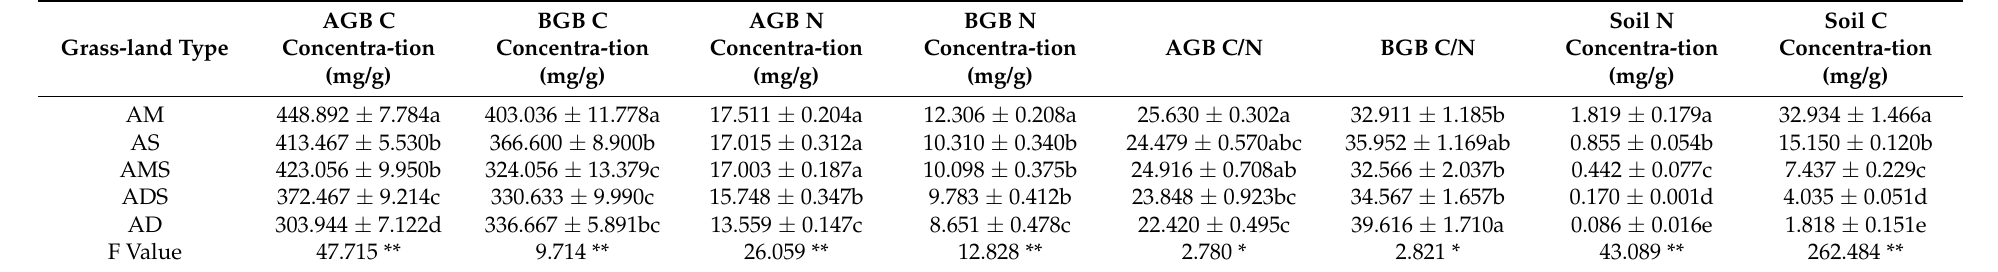
Table 3. Differences of above-ground biomass (AGB) and soil C, N concentrations, below-ground biomass (BGB) and soil C, N concentrations, AGB C/N and BGB C/N ratios in 5 alpine grassland types.